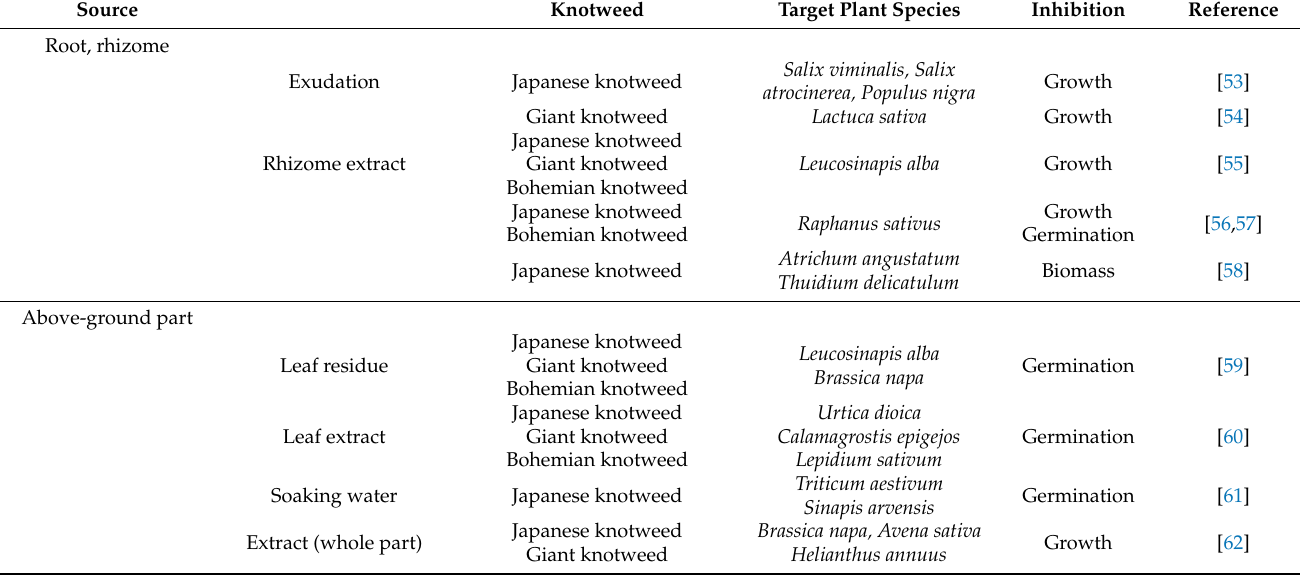
Table 1. Allelopathic activities of roots, rhizomes, and above-ground parts of